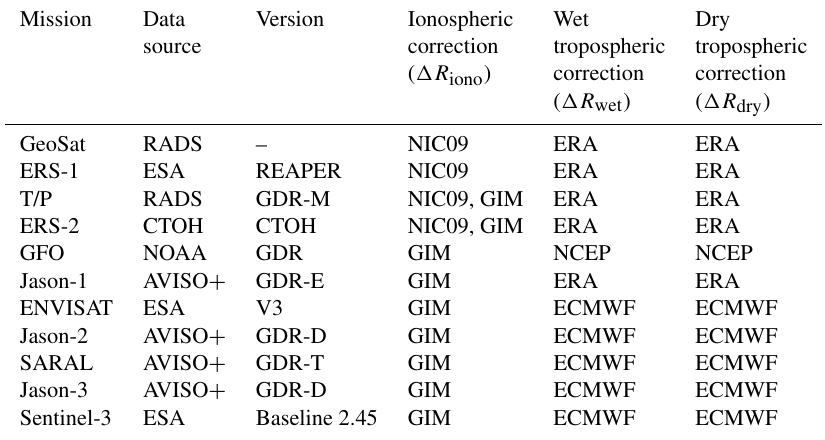
Table 3. The version of altimetry data product and the models of the three atmospheric